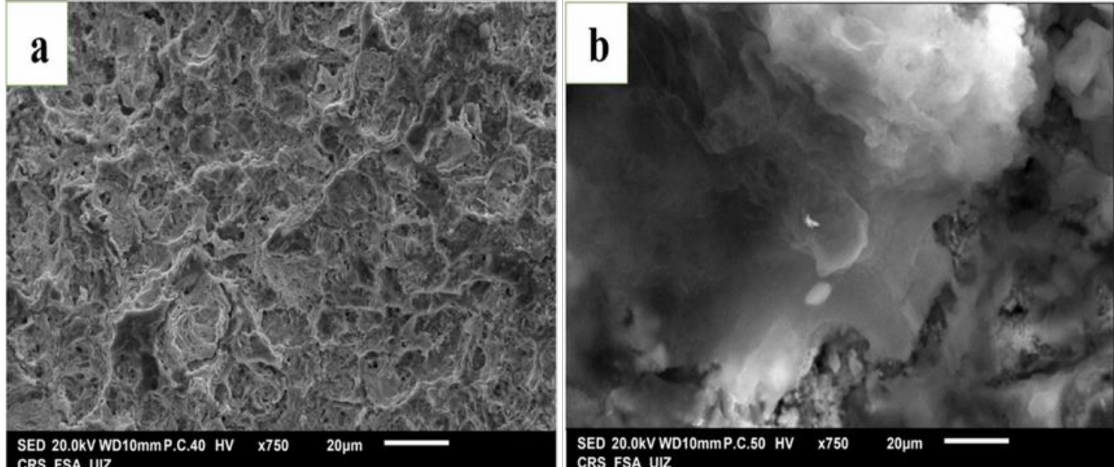
Figure 11. SEM images of the electrode surface before and after use: ( a ) Ti/Pt/SnO 2 surface before use, ( b ) Ti/Pt/SnO 2 surface after use.